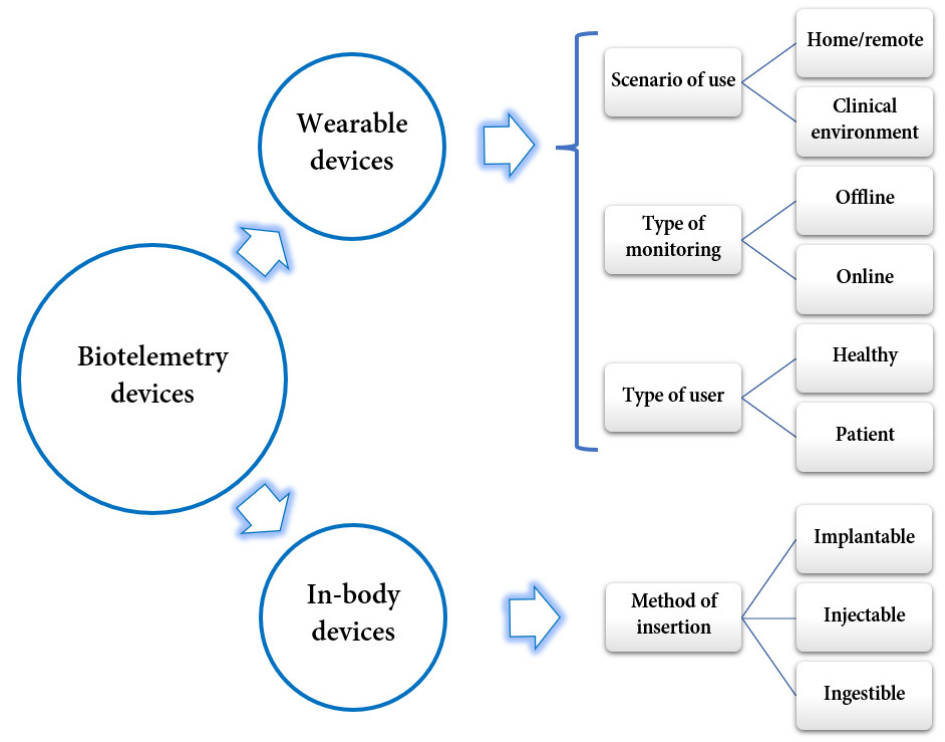
Figure 3. Classification of biotelemetry devices. Created based on information from literature refer- ences [36,38].